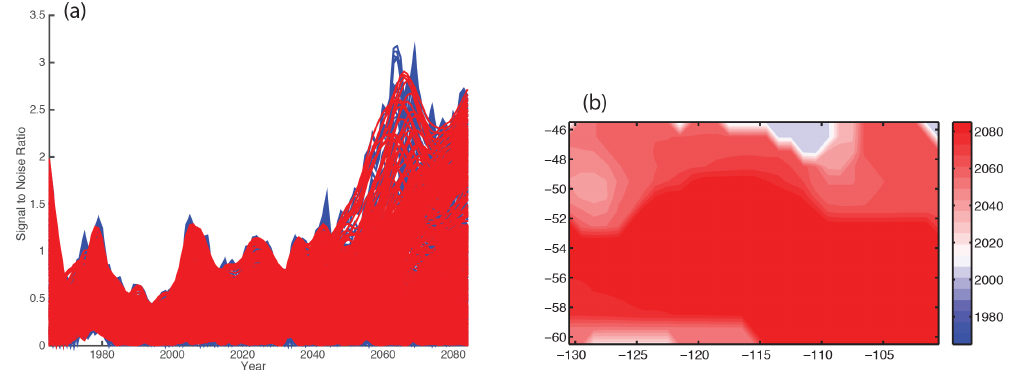
Figure A4. The ToE is considered for the same region, but this time with application of a robust Loess filter with a tolerance window of 10 years applied to the SNR of SST calculated for the individual surface grid points in the domain. The SNR after application of the robust Loess filter is shown in panel (a) in red, superposed over the same blue time series considered in Fig. A3a. The filtering effect on the short timescale maximum excursions of the SNR is evident. The net effect over the full domain of the robust Loess filter is shown in panel (b) , revealing a later ToE over significant portions of the region of interest. A ToE before the present time (pre-2014) is indicated by shades of blue, while a later ToE is indicated with shades of